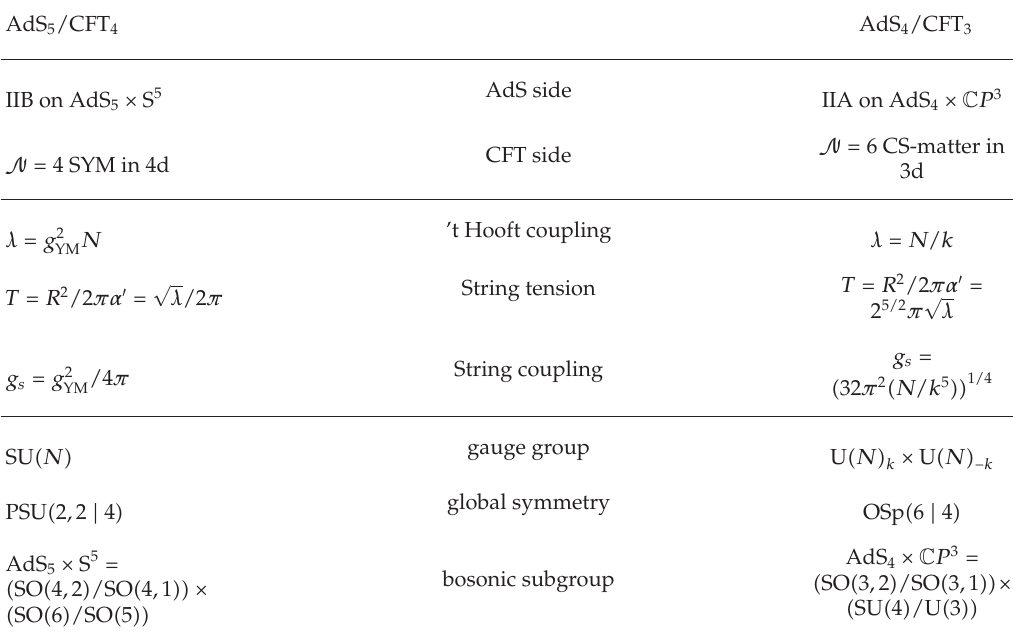
Table 2: Summarized comparison between the two gauge/string